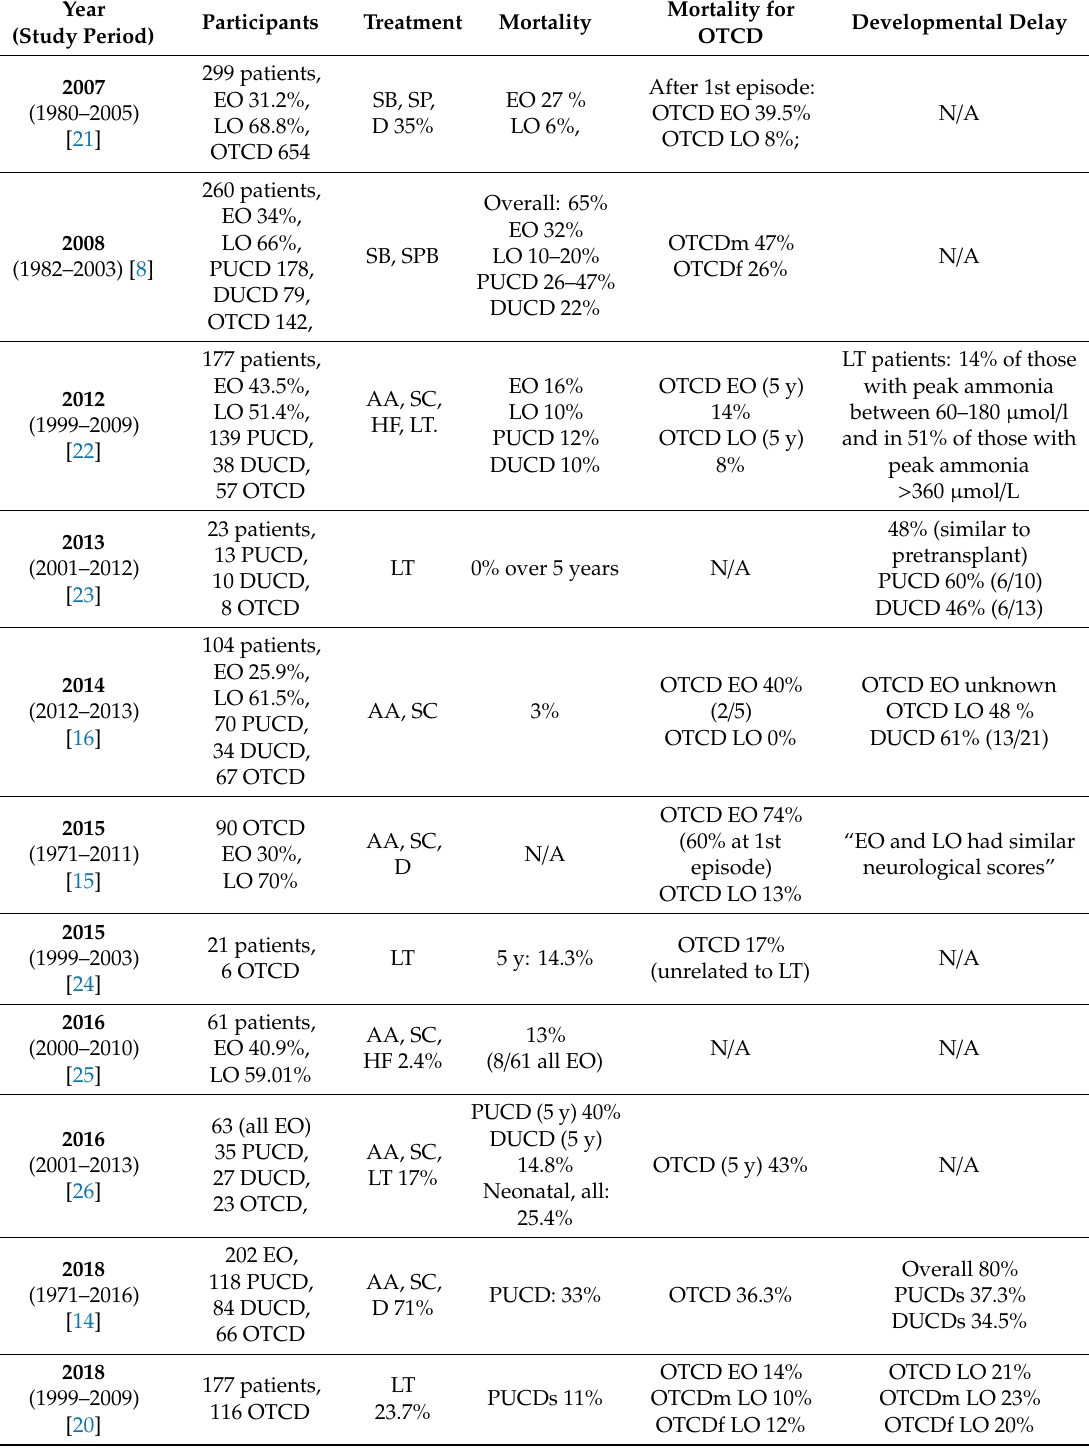
Table 2. Outcomes in proximal urea cycle disorders and ornithine transcarbamylase deficiency (OTCD). Year (Study